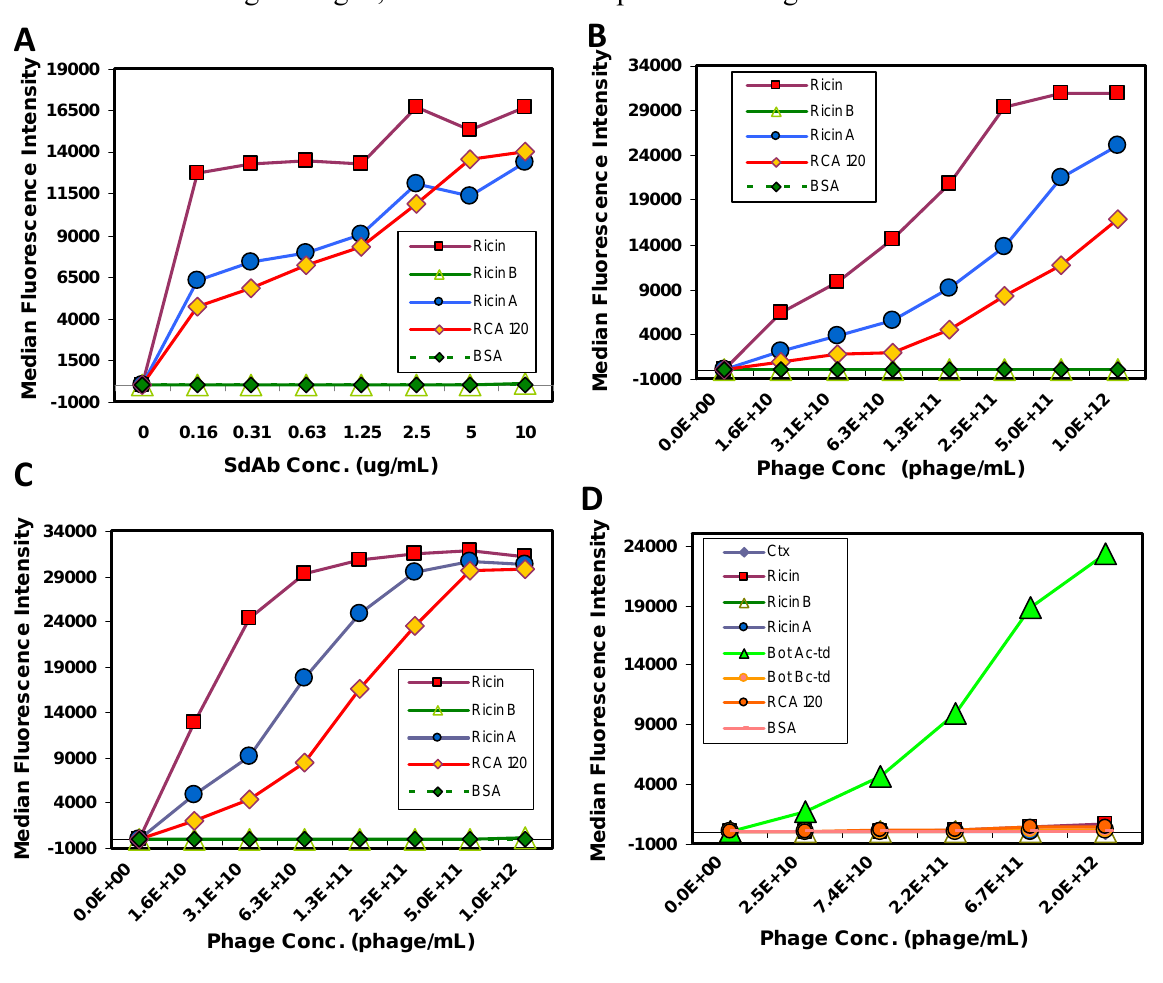
Figure 4: Binding of soluble and phage-displayed C8 to antigen coated microspheres. The binding of various biotinylated tracer reagents was evaluated: (A) sl-Bt-C8 sdAb, (B) sl- Bt-C8 phage, (C) Bt-Lc-Lc-C8 phage. As a control the binding of phage-displayed sdAb A4, a clone known to be specific toward botulinum toxid A complex (Bot Ac-td) is shown, (D) Bt-Lc-Lc-A4 phage. The molar concentration of soluble C8 (MW ~ 16,000 kDa) used in these experiments varied from 10 nM to 625 nM. Molar concentration of phage varied from to 27 pM to 1.7 nM. Results indicate phage-displayed sdAb bind with high specificity toward their target antigen, with minimal nonspecific binding